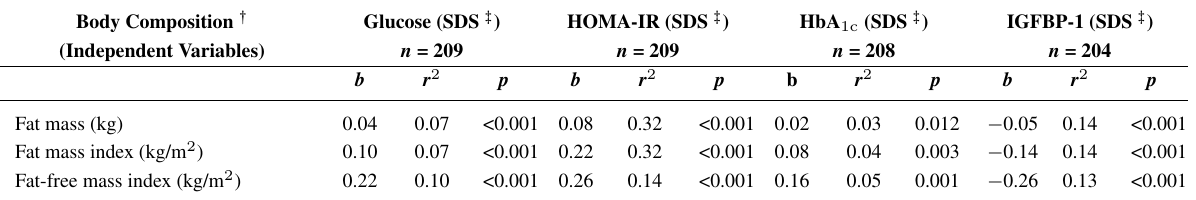
and IGFBP-1) in the 1c